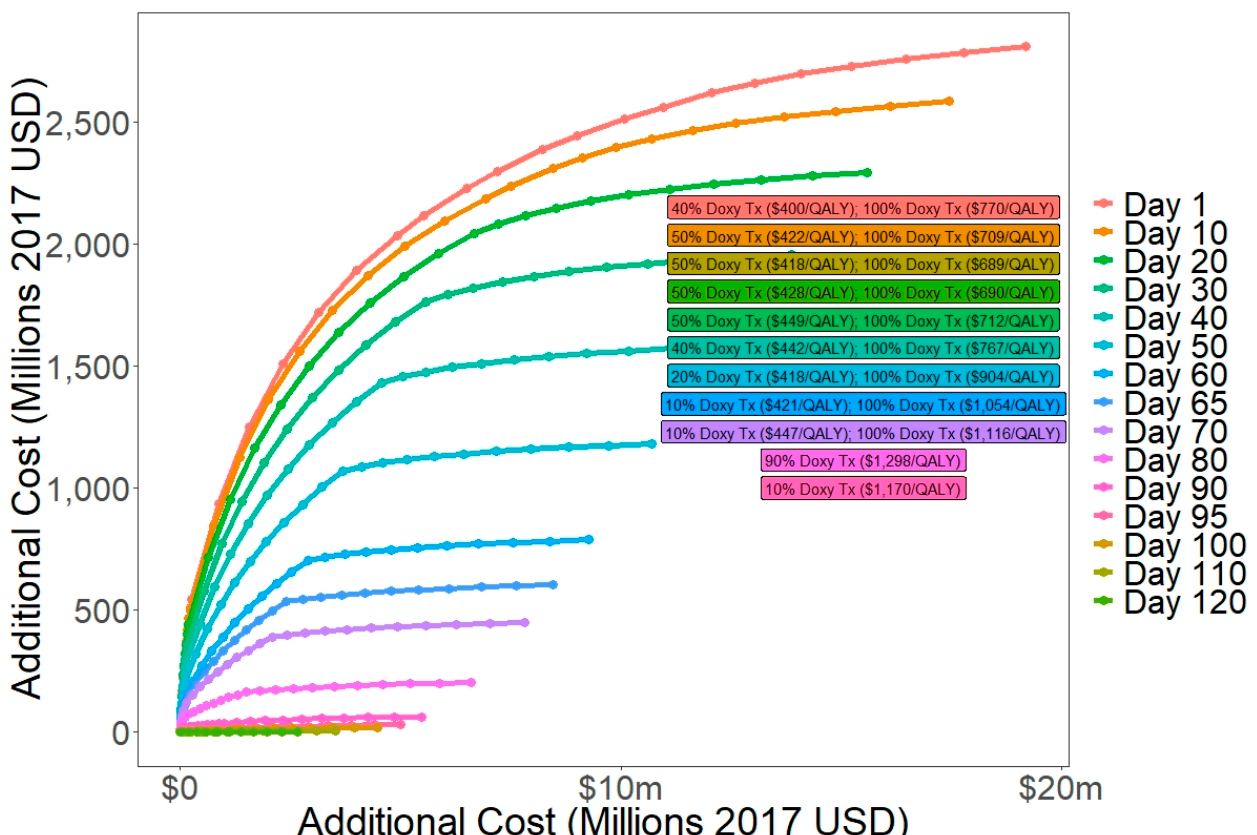
Figure 4. Cost-effectiveness frontiers when comparing single-day decisions.